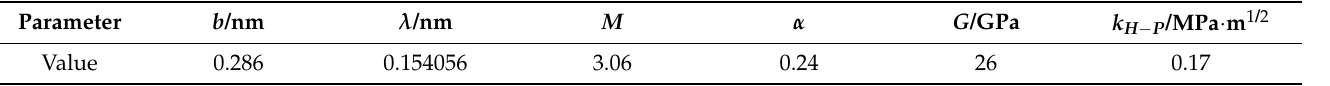
Table 4. Coefficients in the strength calculation formula [23–25].